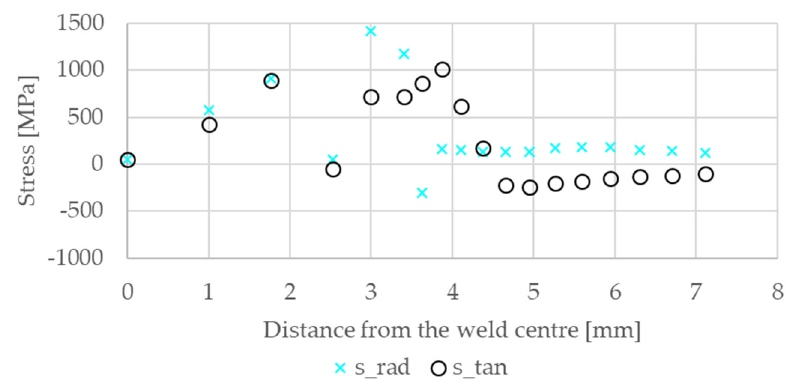
Figure 9. The simulated residual stresses in the radial and tangential direction are shown at the spot weld surface.